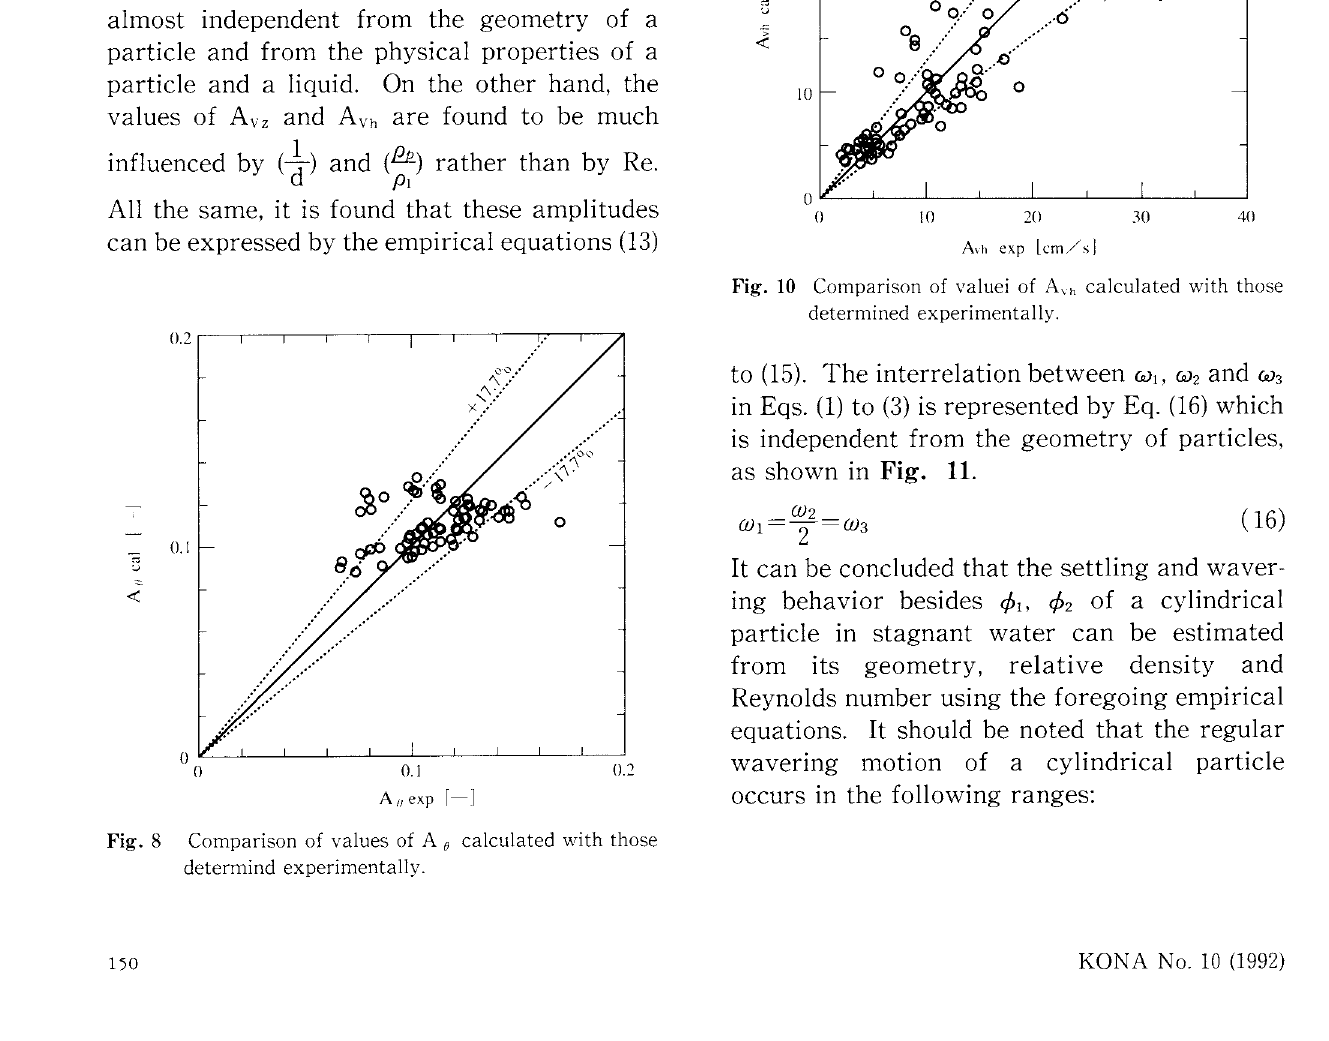
Fig. 10 Comparison of valuei of A, h calculated with those determined